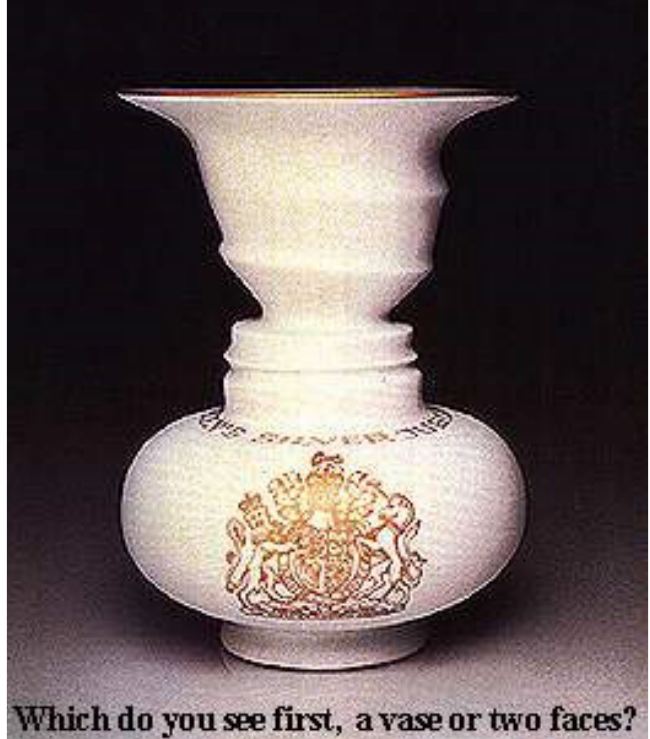
Figure 3. Faces or